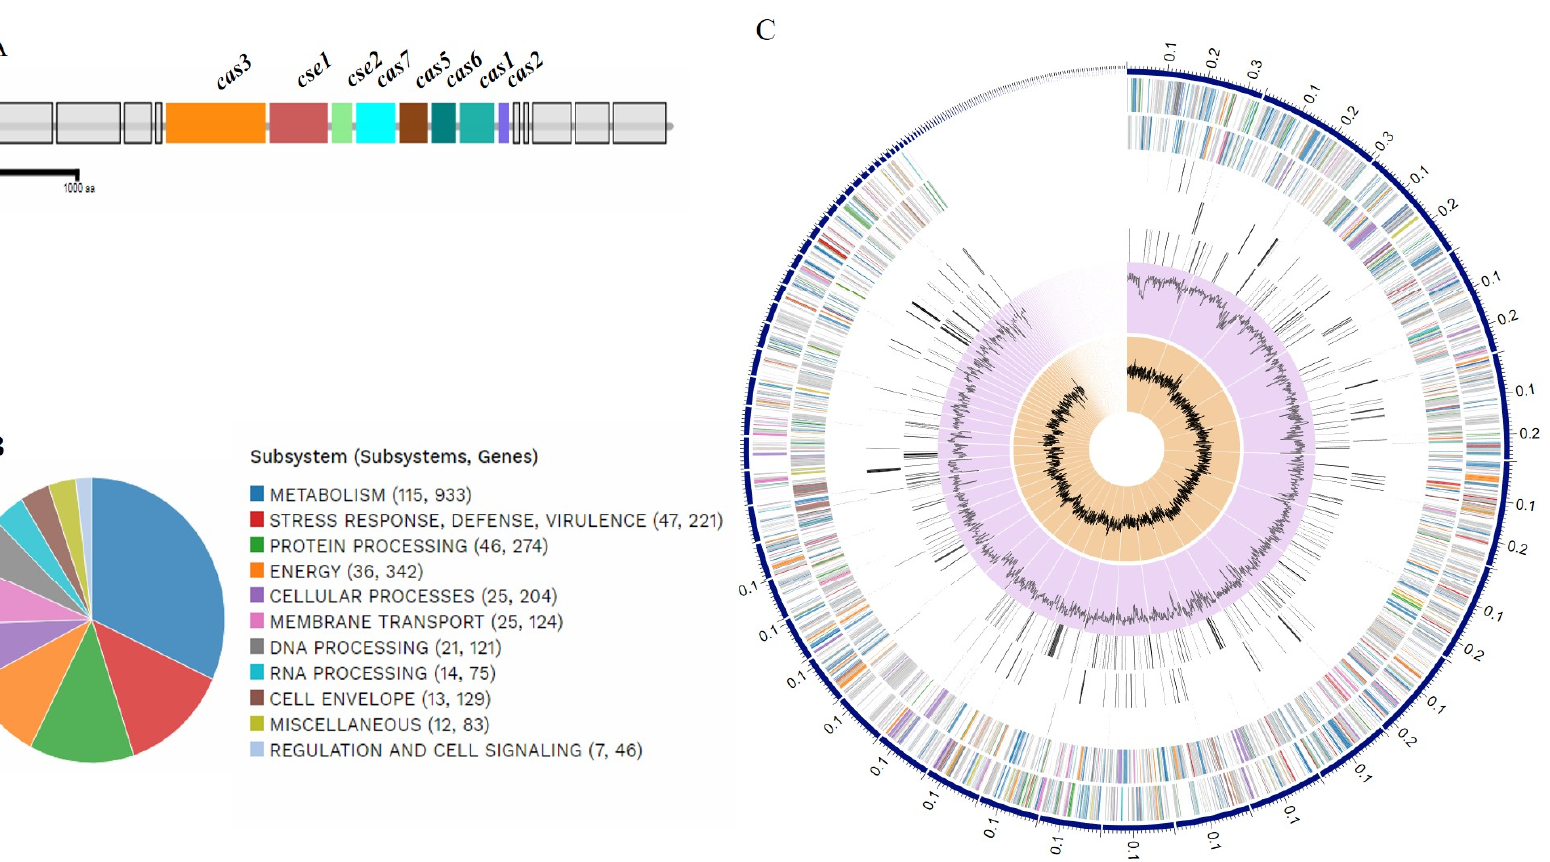
Figure 3. CRISPR locus composition and biological systems assignment in EC121. ( A )—Genomic architecture representation of CRISPR locus in the EC121 genome; the image was obtained in MacSyFinder from genome annotation; ( B )—Representation of EC121 genome composition in subsystems based on protein biological data obtained in silico; ( C )—EC121 schematic genome composition, based on annotation, ordered by contig size. In the circle from outer to the inner portions: forward strand, reverse strand, RNA related genes, antimicrobial resistance, virulence factors, GC content, and GC skew. The colors in forward and reverse strands correspond to the subsystems presented in B. Figure 3B,C were obtained using the comprehensive genome analysis service at PATRIC.